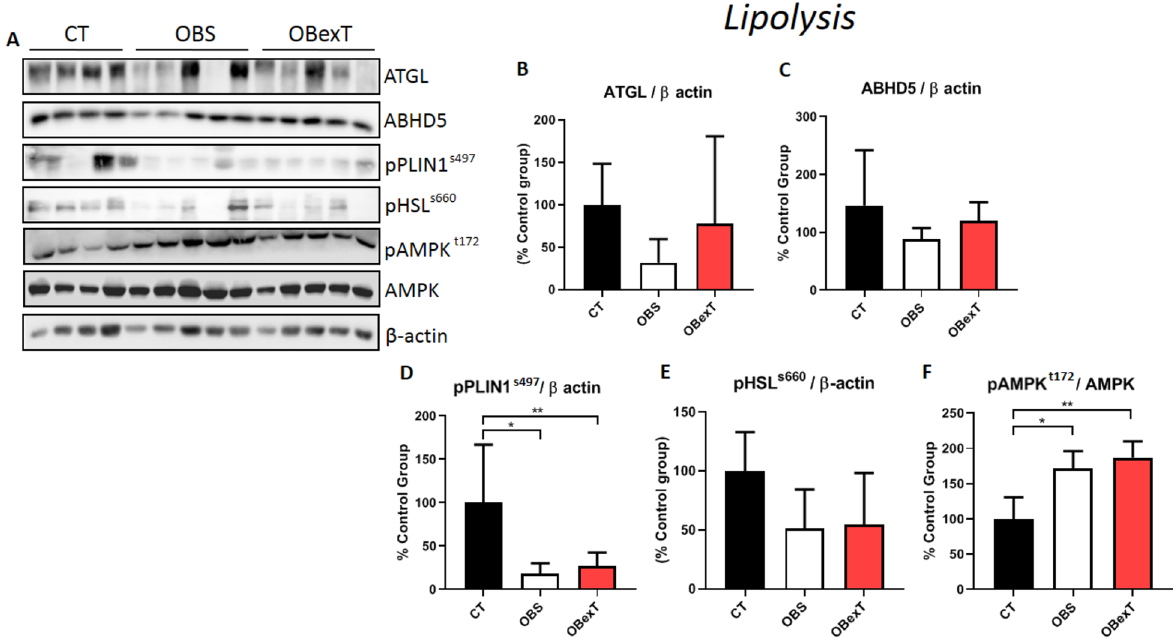
Figure 4. Total protein extract obtained from the subcutaneous adipose tissue was used for Western Blotting experiments. Uncut images can be viewed in the supplementary material. The membranes were cut at the specific height of the target protein. ( A ) The protein content of ( B ) ATGL, ( C ) ABHD5, ( D ) pPLIN1 ser497 , ( E ) pHSL s660 and ( F ) pAMPK t172 . The signal of statistical difference are represented as follows, * p < 0.05 CT versus OBS, ** p < 0.05 CT versus OBexT and *** p < 0.05 OBS versus OBexT (n = 4 CT group; n = 5 OBS group; n = 5 OBexT group). One-way Anova statistical analysis was used, followed by Tukey’s